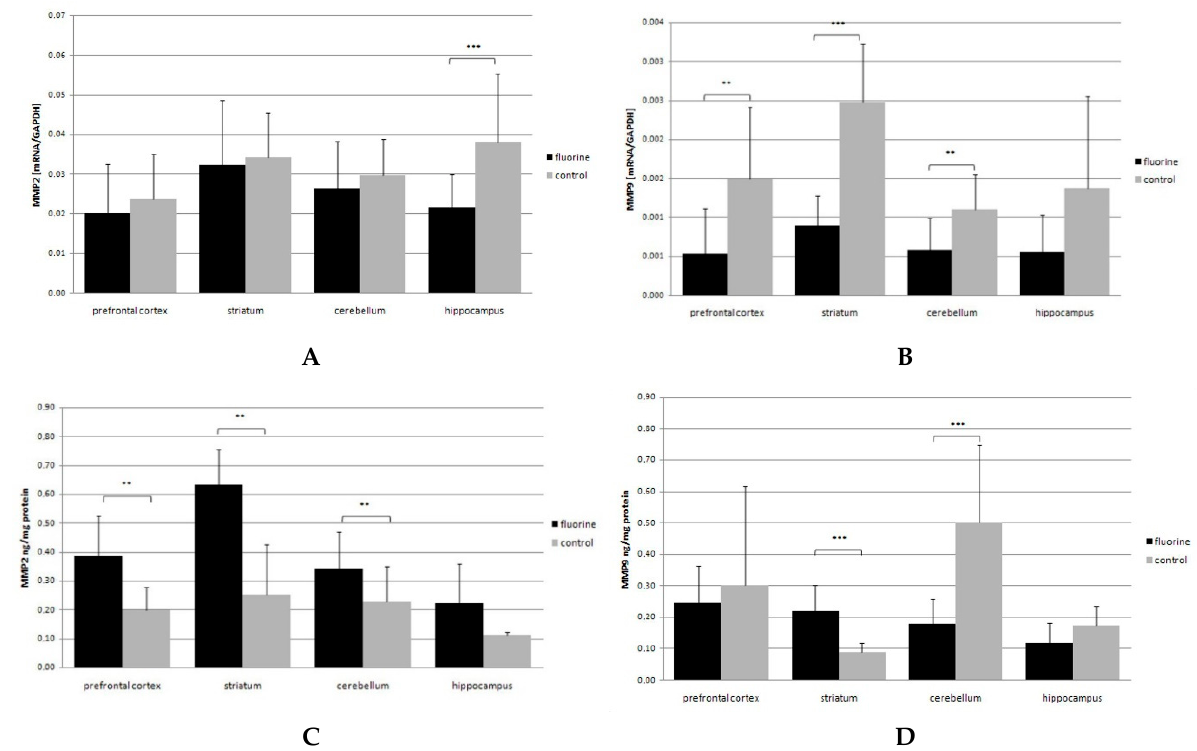
Figure 1. MMP2 and MMP9 mRNA ( A , B ) and protein ( C , D ) expression in analyzed brain structures (prefrontal cortex, striatum, cerebellum, hippocampus). Black bars represent means ± SD of mRNA ( A , B )/protein ( C , D ) level in the Fluoride (F)-exposed group, while gray bars represent controls. * p ≤ 0.05, ** p ≤ 0.005, *** p ≤ 0.001 (Mann–Whitney U test), n = 6.